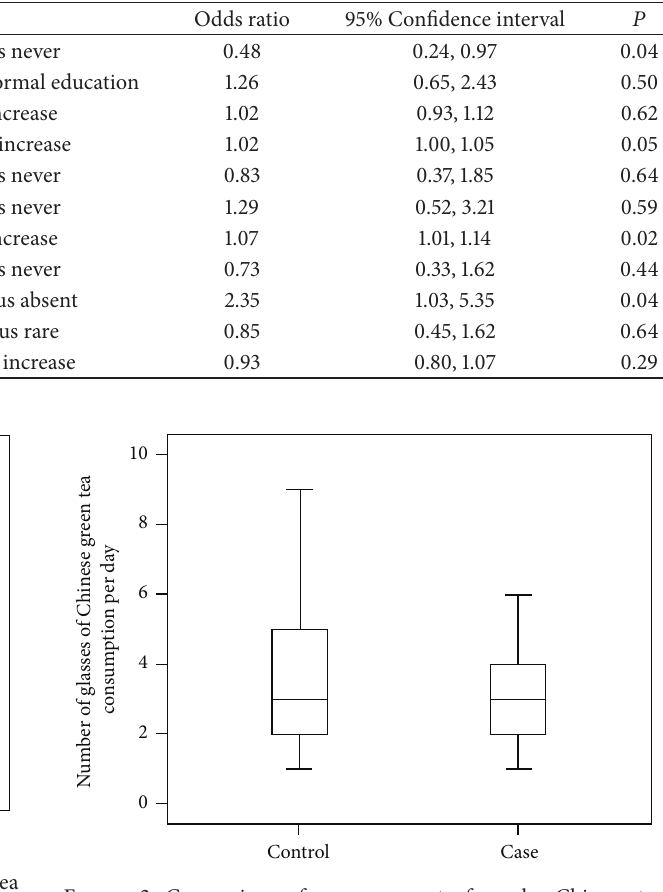
Figure 2: Comparison of mean amount of regular Chinese tea consumption per day between the case and control